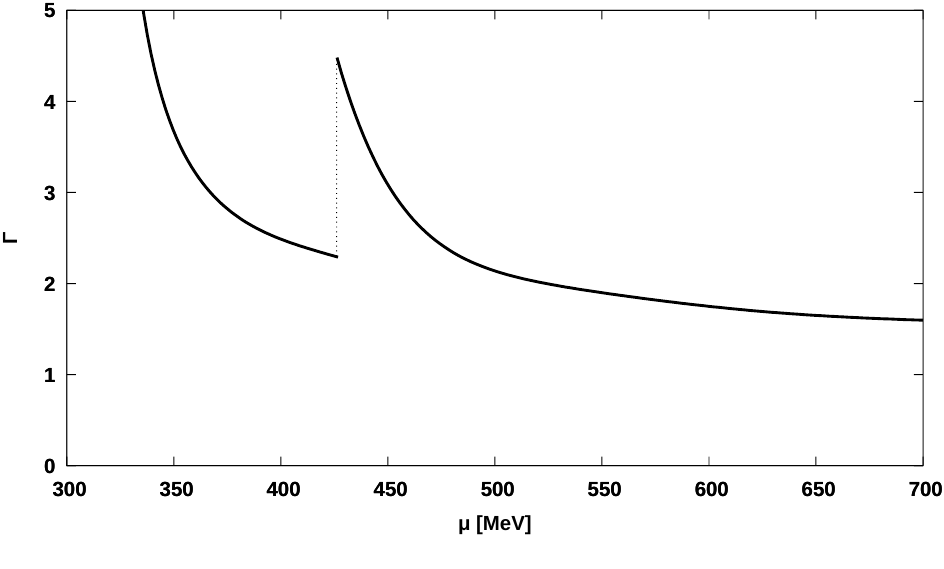
Figure 7 . Adiabatic index at T =